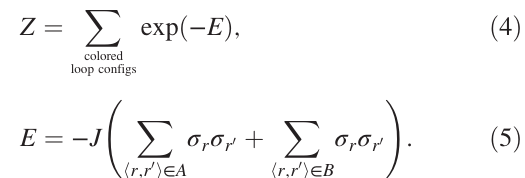
FIG. 3. Néel order parameter N (dashed lines) and VBS order parameter j ~ φ j (solid lines) as a function of J for several system sizes L . Continuous curves are interpolations using the multiple histogram method [43]. Inset: Pseudocritical couplings J (cid:2) ð L Þ obtained from various observables [ N (blue rhombi), j ~ φ j (down- pointing magenta triangles), crossings of 4 N & j ~ φ j (grey stars), C (up-pointing green triangles), B φ (red (black squares), N s circles), and V (turquoise